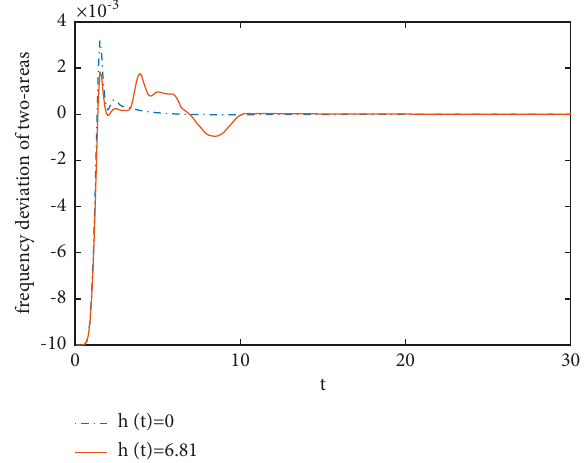
Figure 11: Frequency responses with h � 6 . 81 ( μ � 0 . 5 ) and without delay of two areas.